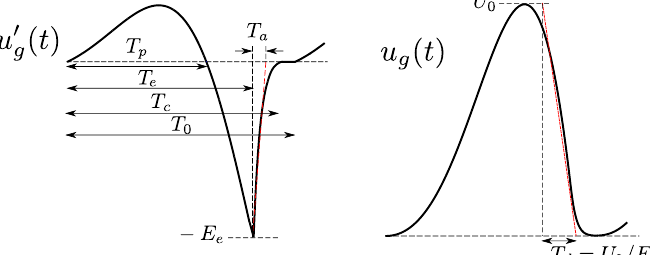
Figure 3. Glottal flow u g ( t ) and its time derivative u (cid:48) g ( t ) according to the LF (Liljencrants–Fant) model [12]. T p is the rise time, T e is the duration of the open phase, T a corresponds to the effective duration of the return phase, T c is the location of the complete closure, T d is the declination time, and T 0 is the period. U 0 is the peak of the glottal flow and E e corresponds to the negative amplitude of the differentiated glottal